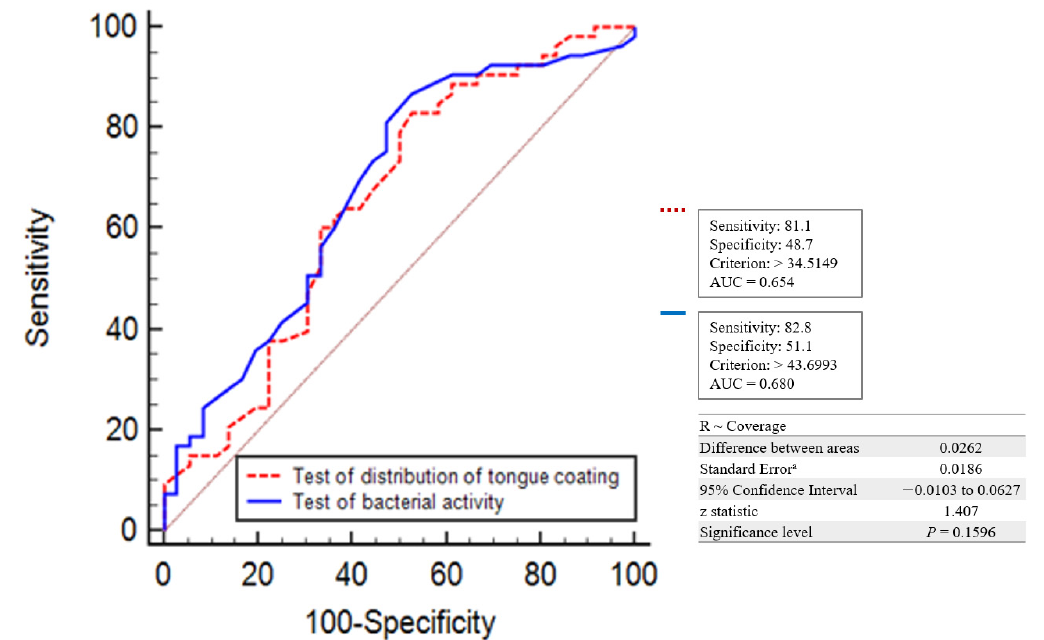
Figure 5. Comparison of accuracy between the test for the distribution of tongue coating and the test for bacterial activity. for bacterial